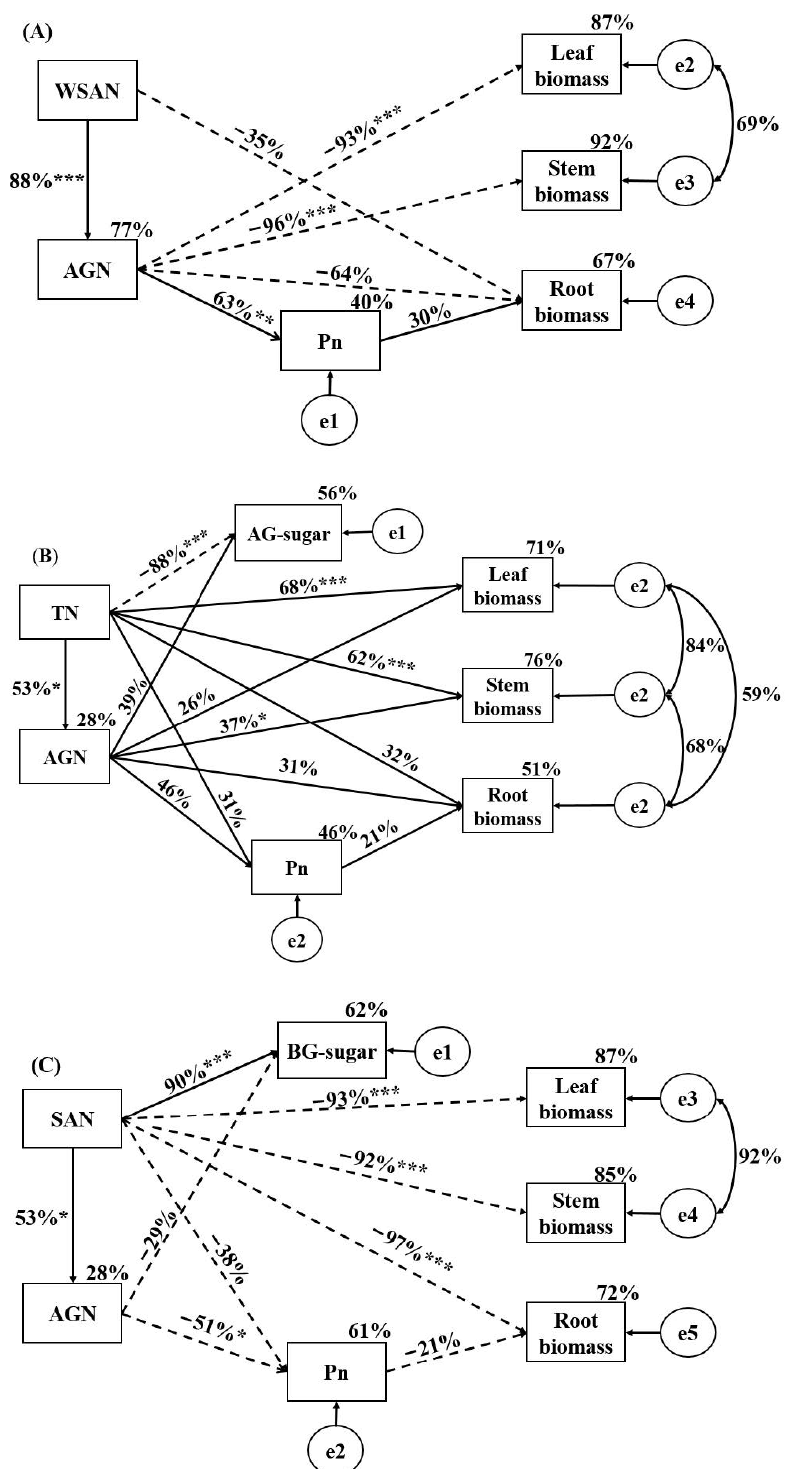
Figure 7. Structural equation modeling of the selected soil fertility variables for functional traits of early- ( A ), mid- ( B ), and late-successional species ( C ). Solid and dashed arrows represent positive and negative correlations, respectively. *** p < 0.001, ** p < 0.01, * p < 0.05.